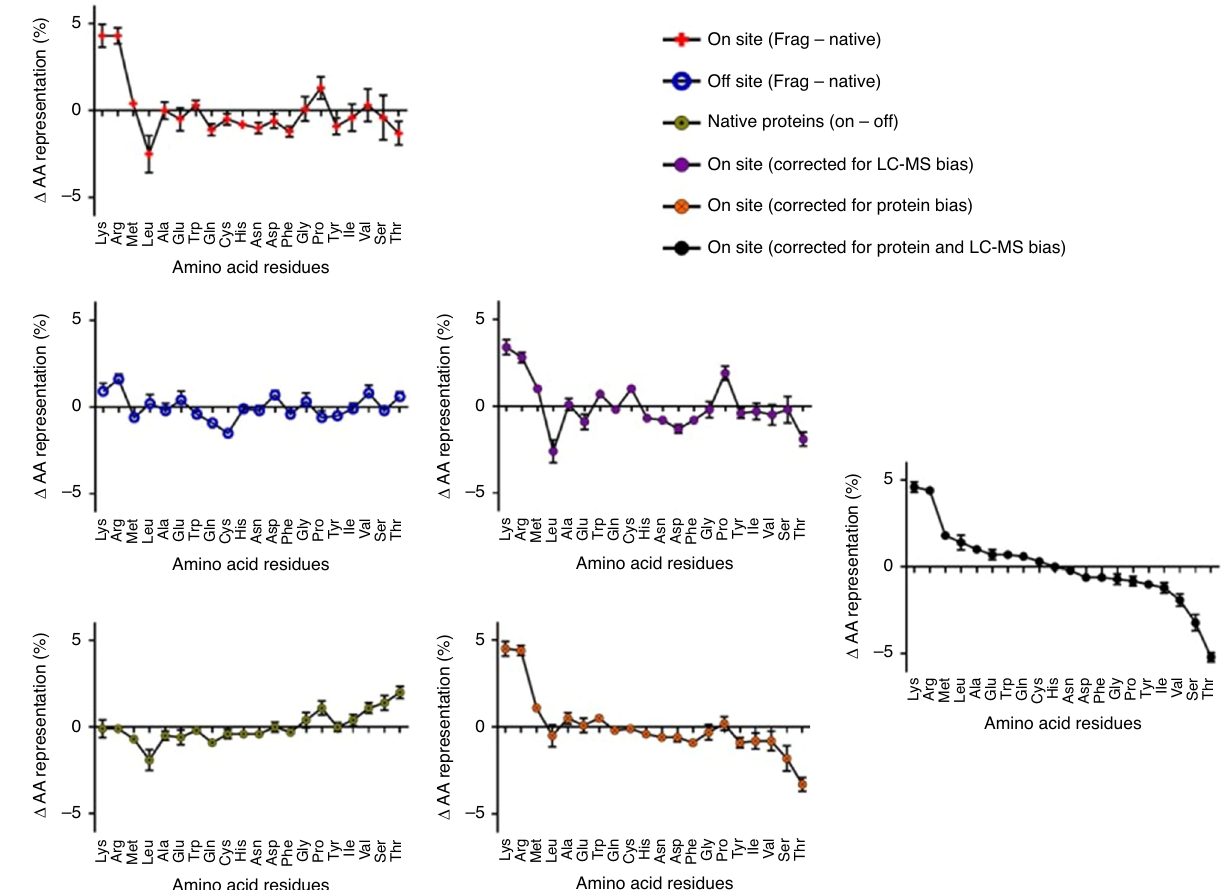
Fig. 5 Changes in amino acid distributions from proteins identi fi ed through LC-MS. Amino acid distributions for on-site proteins between those found in LC – MS fragments and in nature (red); for off-site proteins between those found in LC – MS fragments and in nature (blue) representing the bias of the trypsin fragmentation and the LC – MS – MASCOT system; for native proteins between those found on- and off-site (yellow) representing the preference of the amino acid distribution between on- and off-site proteins; and various correction subtractions (purple or orange are partial corrections and black includes all corrections). Error bars are standard deviations of the mean ( n ≥ 16